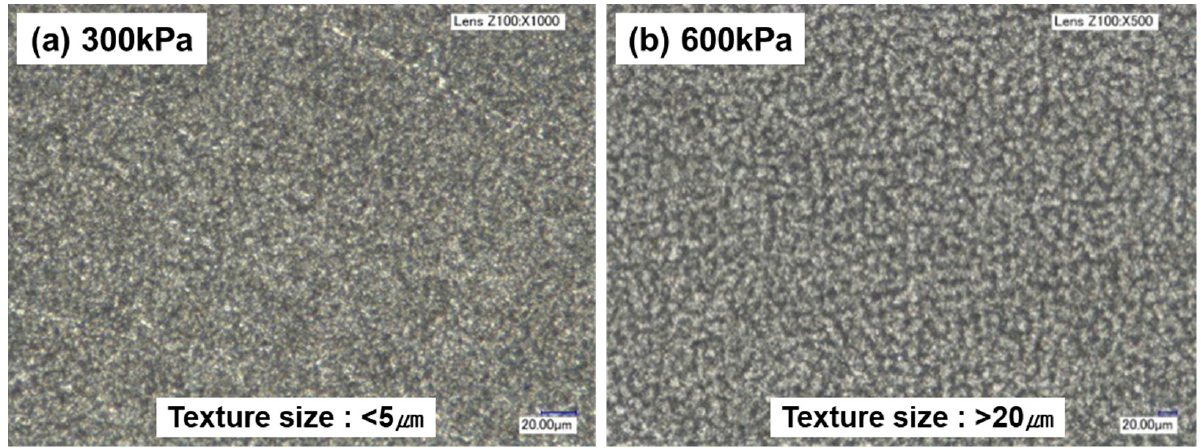
Figure 6. Optical microscopic images of surfaces that were machined at di ff erent pressures.